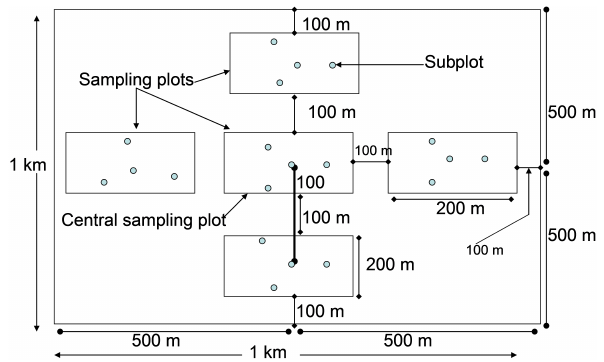
Figure 1. Adapted sampling design of soil samples in northeast Wellega, Ethiopia (after Vågen and Winowiecki, 2013, Vågen et al., 2013, and Abegaz et al.,